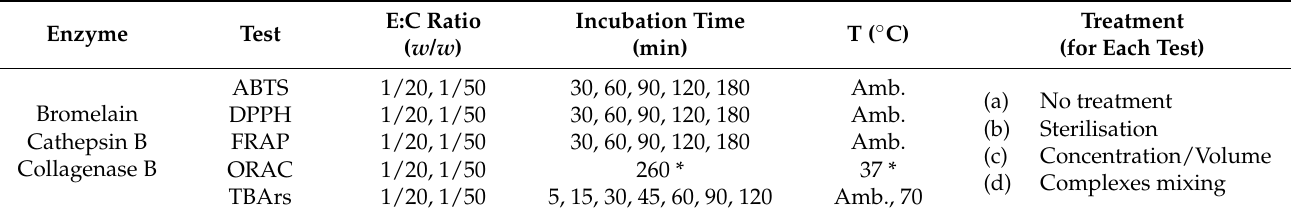
Table 2. Summary of the tests carried out (E:C = enzyme:collagen